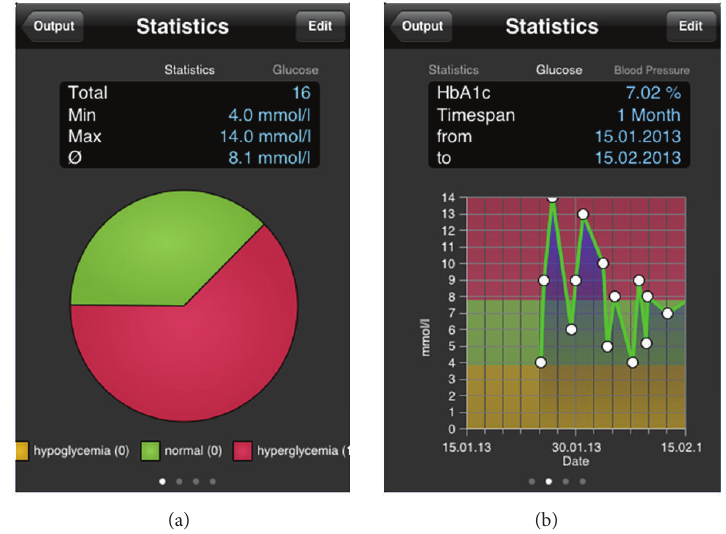
Figure 3: Mobil Diab mobile application: output screens and blood glucose graph.